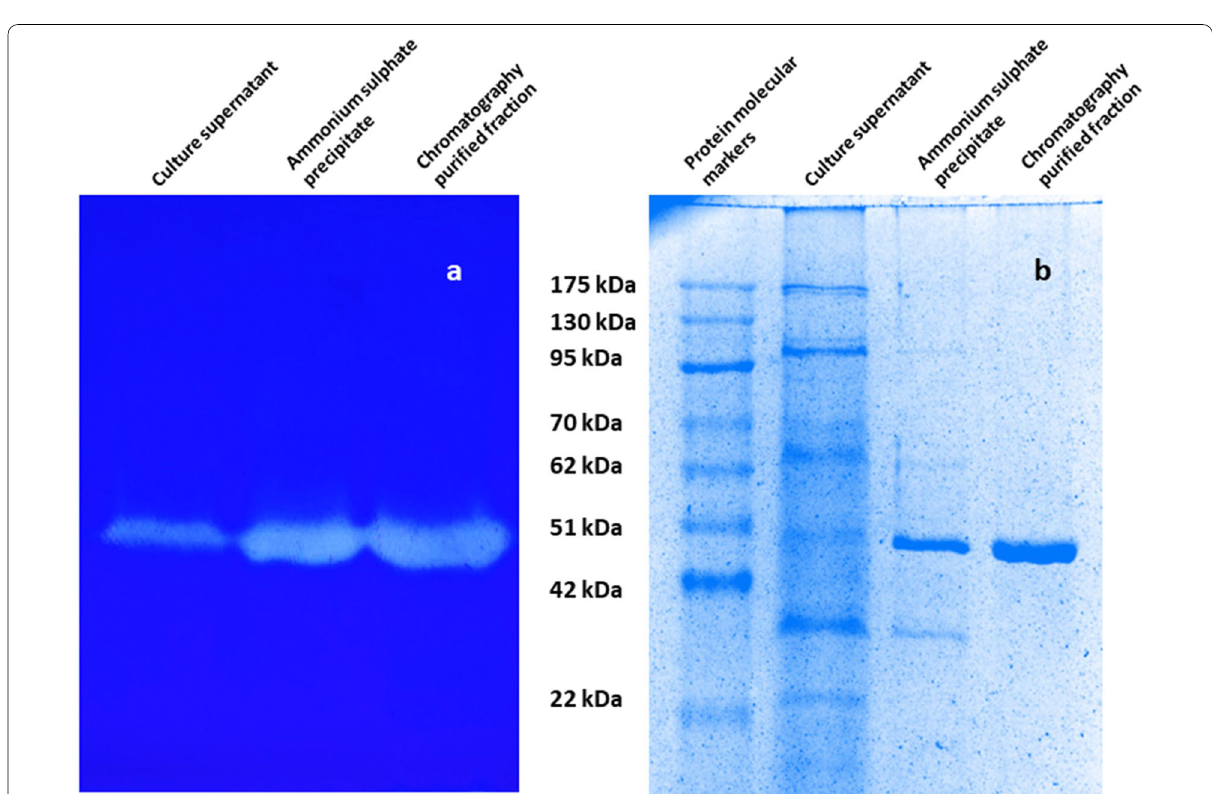
Fig.4 a Casein Zymogram and b SDS-PAGE of serratiopeptidase from S. marcescens